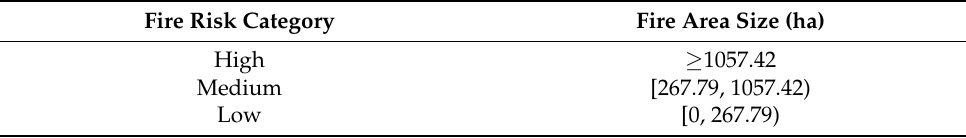
Table 2. Fire risk